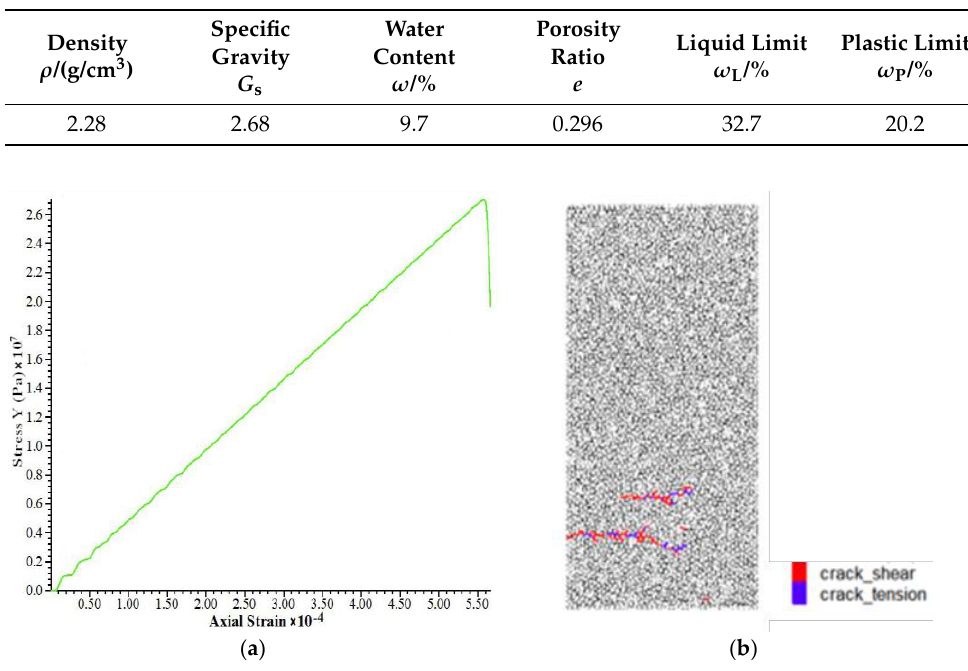
Figure 6. Calibration of uniaxial stretching parameters, ( a ) Stress strain curve, ( b ) break mode.